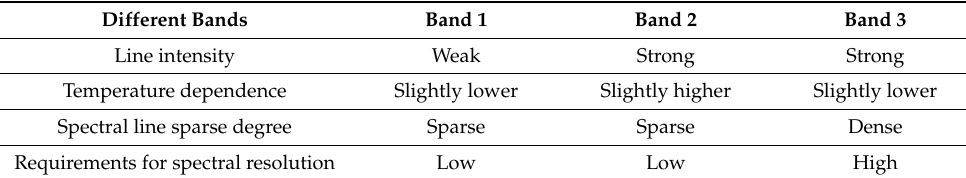
Figure 6. Response of spectrum of each target band to temperature perturbation. Where, ( b ) is the partial enlarged drawing of 95–105 km for ( a ).